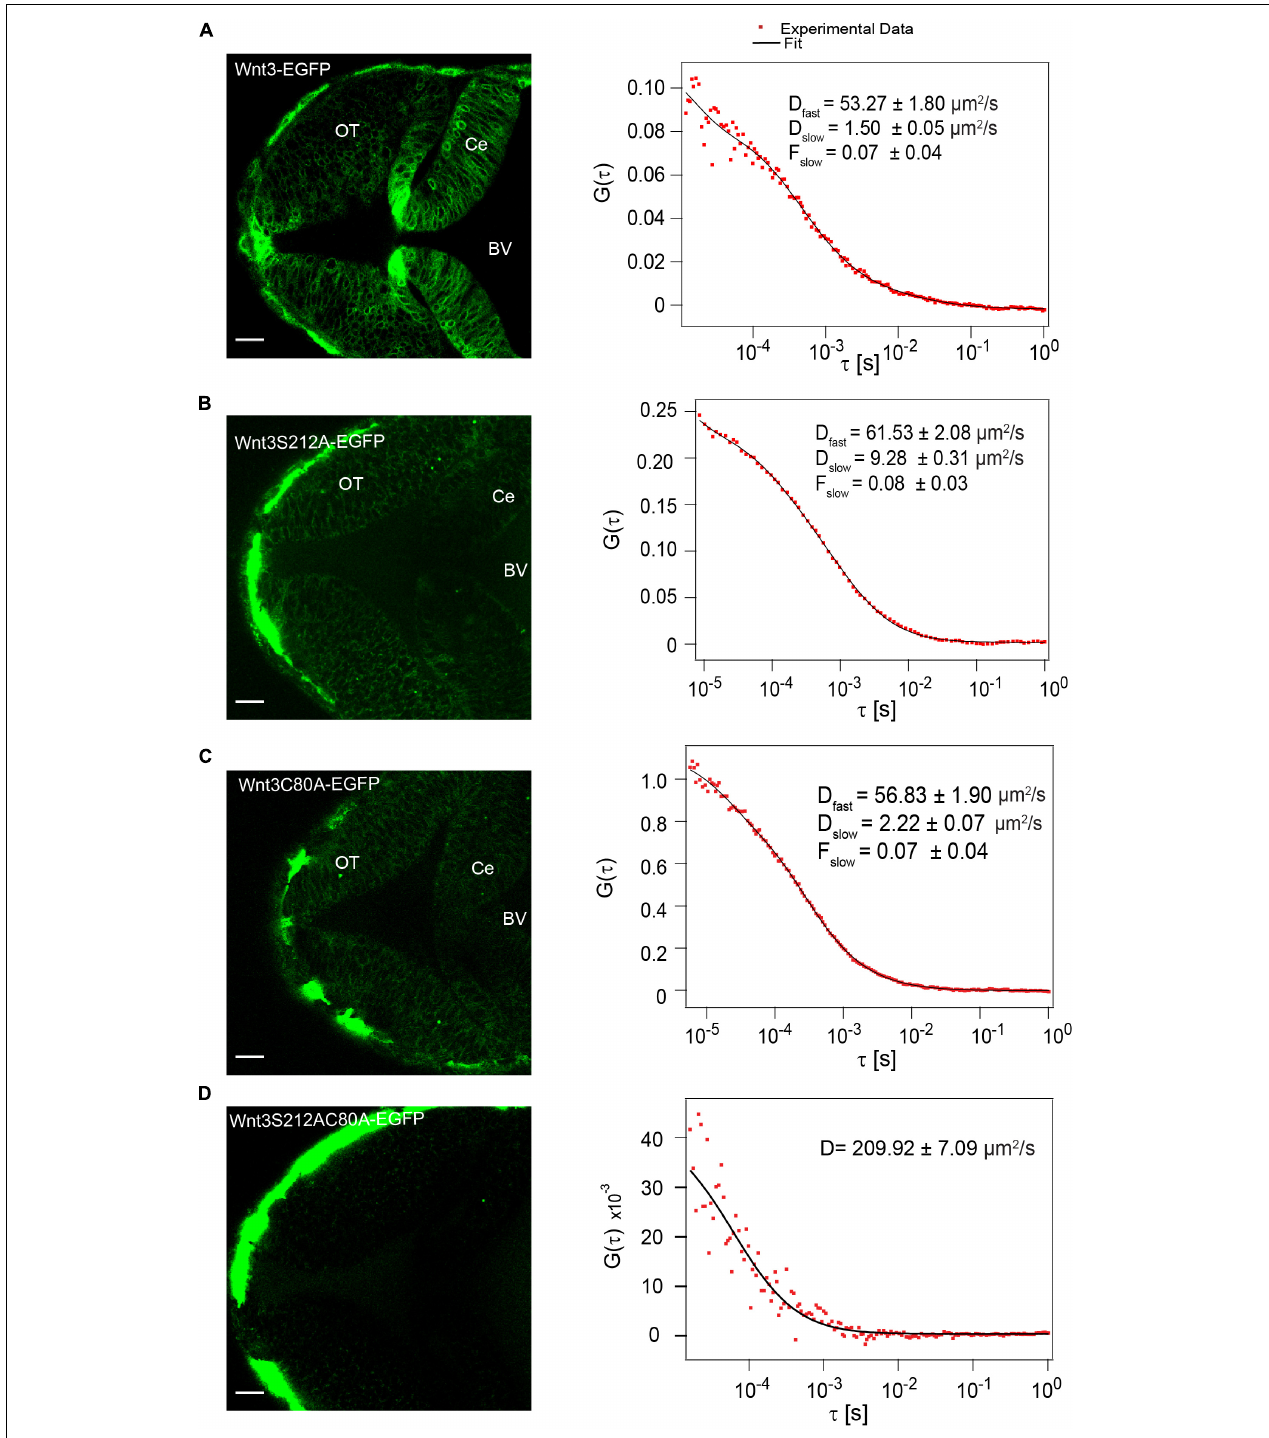
FIGURE 2 | Influence of C80 and S212 lipidation on secretion in vivo . (A) Expression of Wnt3-EGFP in the zebrafish brain at ∼ 48 hpf (left) and a representative autocorrelation function (ACF; dots) and fit (line) of a Wnt3-EGFP FCS measurement in the BV (right). (B) Expression of Wnt3S212A-EGFP in the zebrafish brain at ∼ 48 hpf (left) and a representative autocorrelation function (ACF; dots) and fit (line) of Wnt3S212A-EGFP FCS measurement in BV (right). (C) Expression of Wnt3C80A-EGFP in the zebrafish brain at ∼ 48 hpf (left) and a representative autocorrelation function (ACF; dots) and fit (line) of a Wnt3C80A-EGFP FCS measurement in the BV (right). (D) Expression of Wnt3S212AC80A-EGFP in the zebrafish brain at ∼ 48 hpf (left) and a representative autocorrelation function (ACF; dots) and fit (line) of Wnt3S212AC80A-EGFP FCS measurement in BV (right). The FCS curves were fitted using 3D-2particle-1triplet model. BV, fourth brain ventricle; Ce, cerebellum; OT, optic tectum. Orientation: anterior to the left. Scale bar 20 µ m.